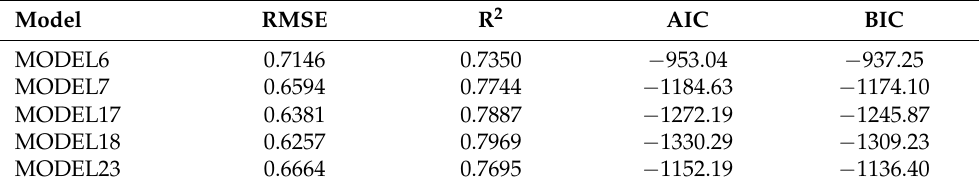
Table 4. Goodness-of-fit statistics of %NLINMIX for crown profile models. Model